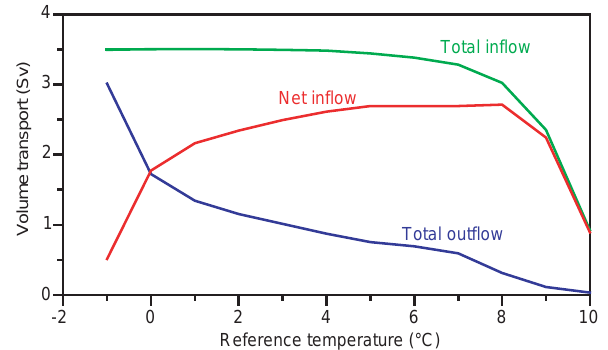
Fig. 7. The volume transport (using core interpolation) through the section of water warmer than a specified reference temperature plot- ted against the reference temperature. Total inflow (towards the Nor- wegian Sea) and total outflow (from the Norwegian Sea) volume transports are shown separately as well as their difference (net in- flow).